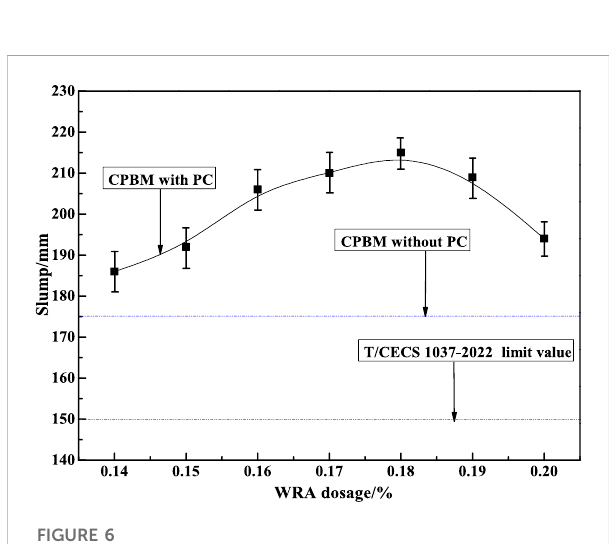
FIGURE 6 Effect of WRA dosage on the working properties of BFPBM.